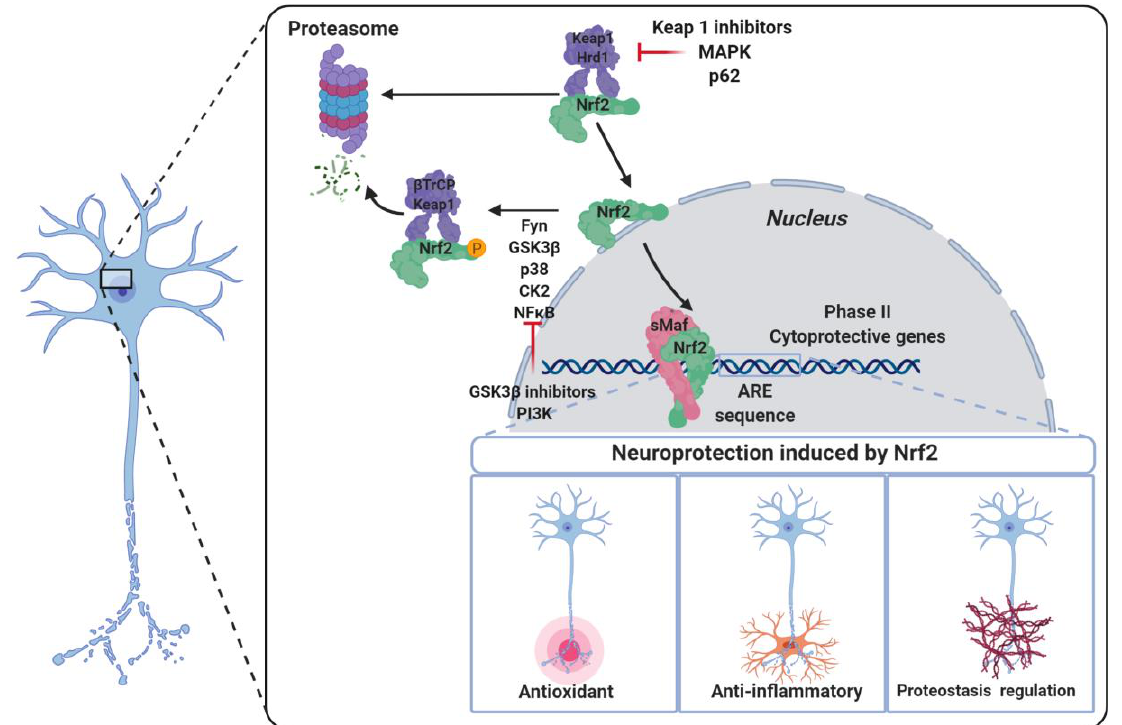
Figure 16. A summary of the main NRF2 regulation mechanisms. KEAP1 represents the main negative regulatory protein of NRF2 coding its proteasomal degradation to maintain its expression at low levels. KEAP1–NRF2 interaction can be blocked by the activity of protein– protein inhibitors, MAPKs and p62. Hrd1 also induces NRF2 proteasomal degradation, helping